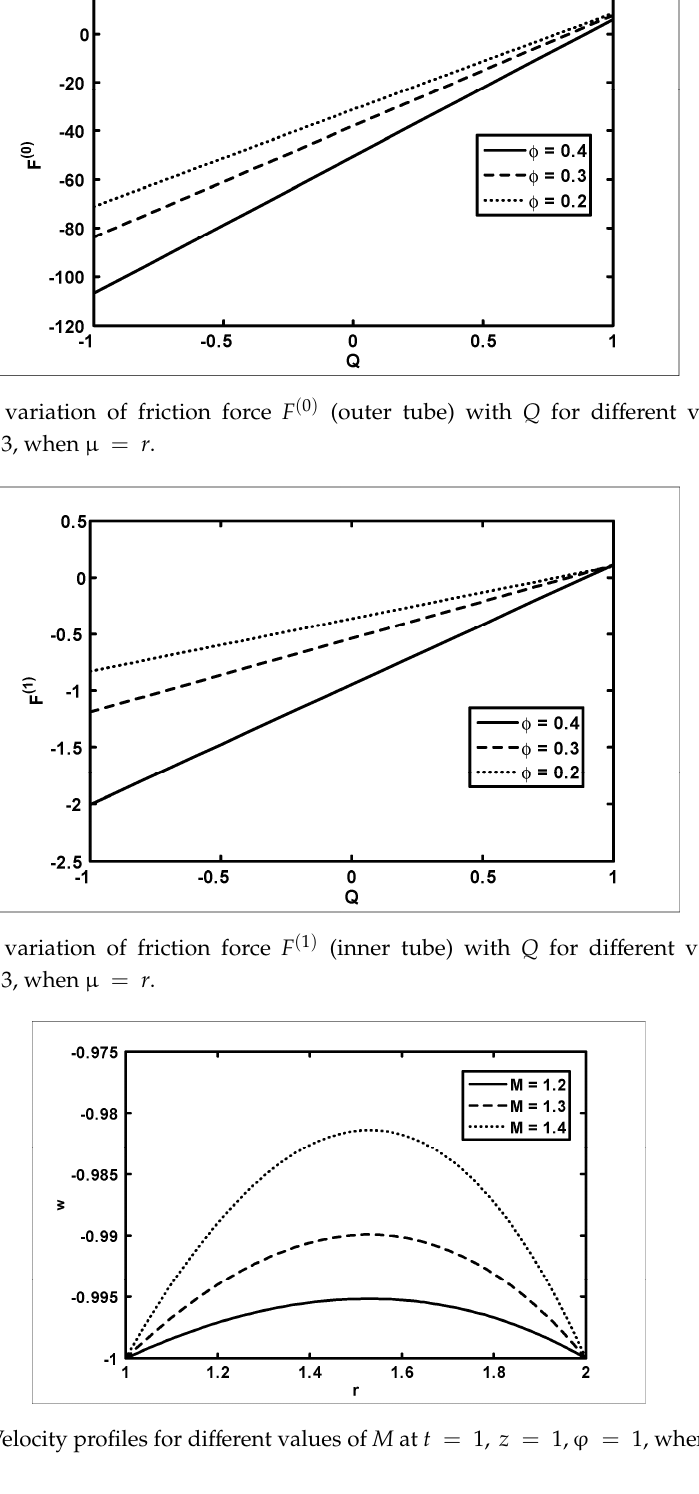
Δ with Q for different values of φ at